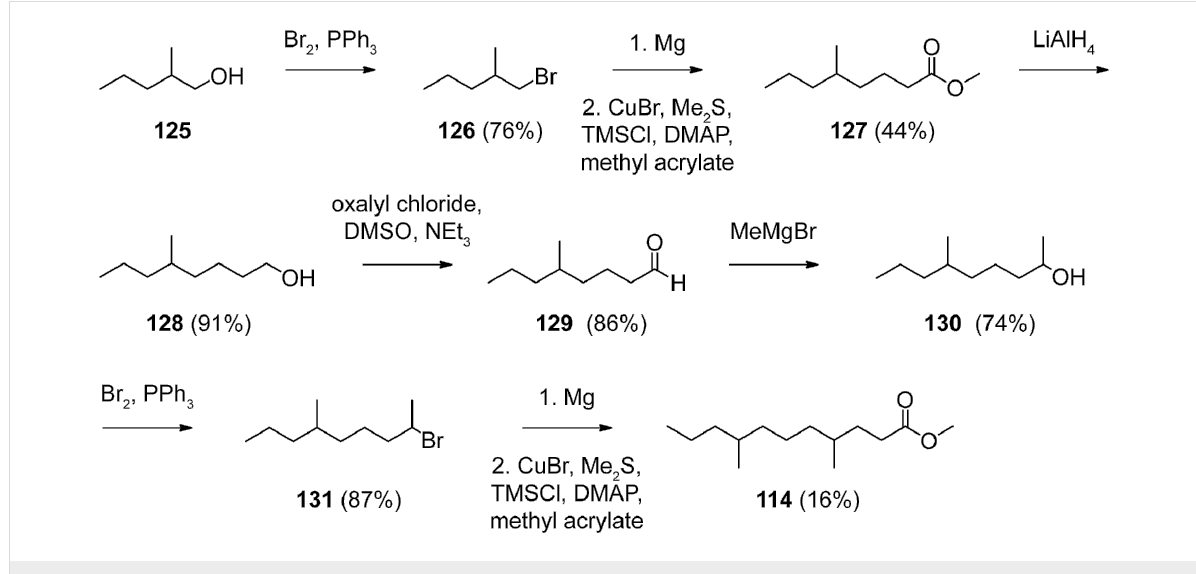
acrylate was less efficient than for primary bromides, but gave the desired product 114 in low yield. The identity to the natural product was confirmed by comparison of GC–MS